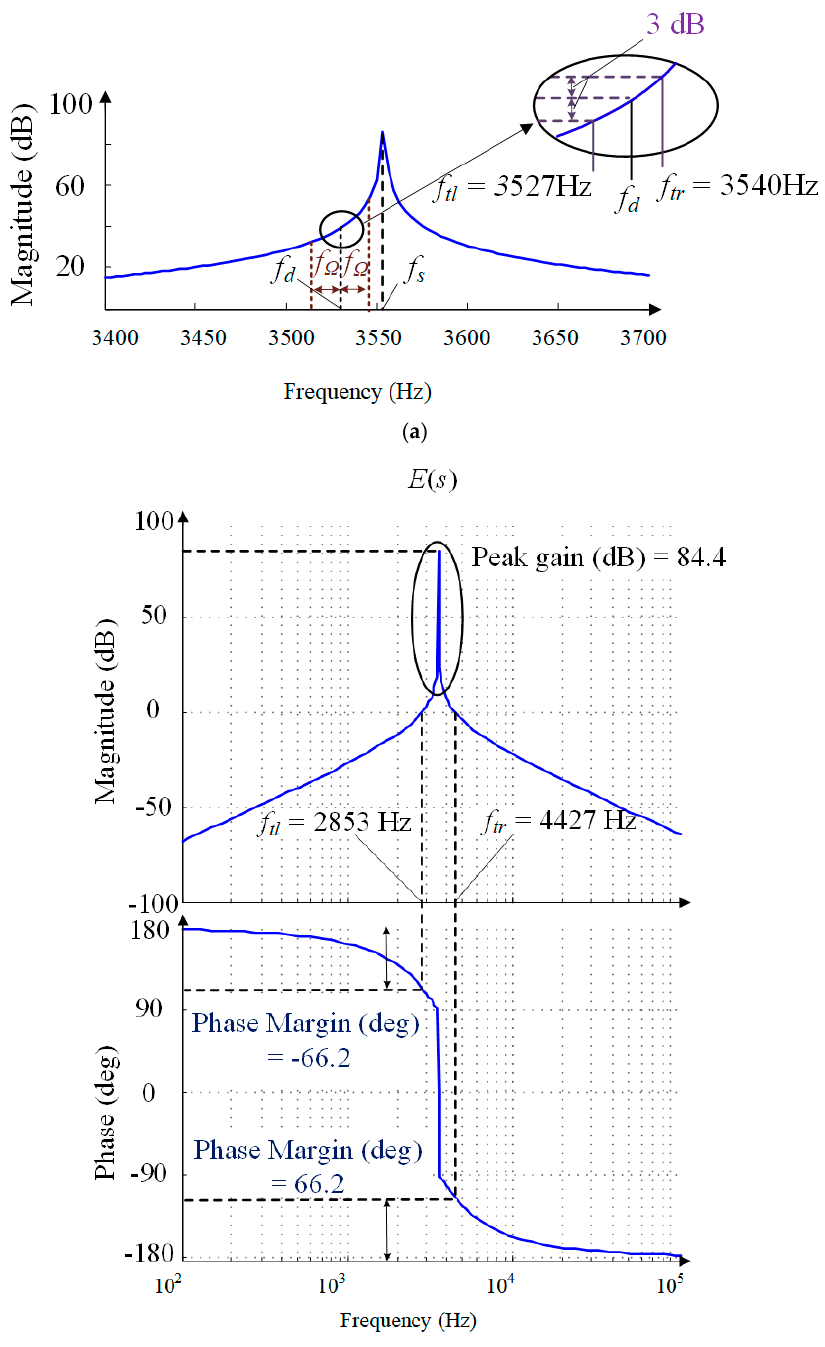
Figure 5. Frequency-domain responses of the open loop system E ( s ): ( a ) enlarged view; ( b ) frequency response.